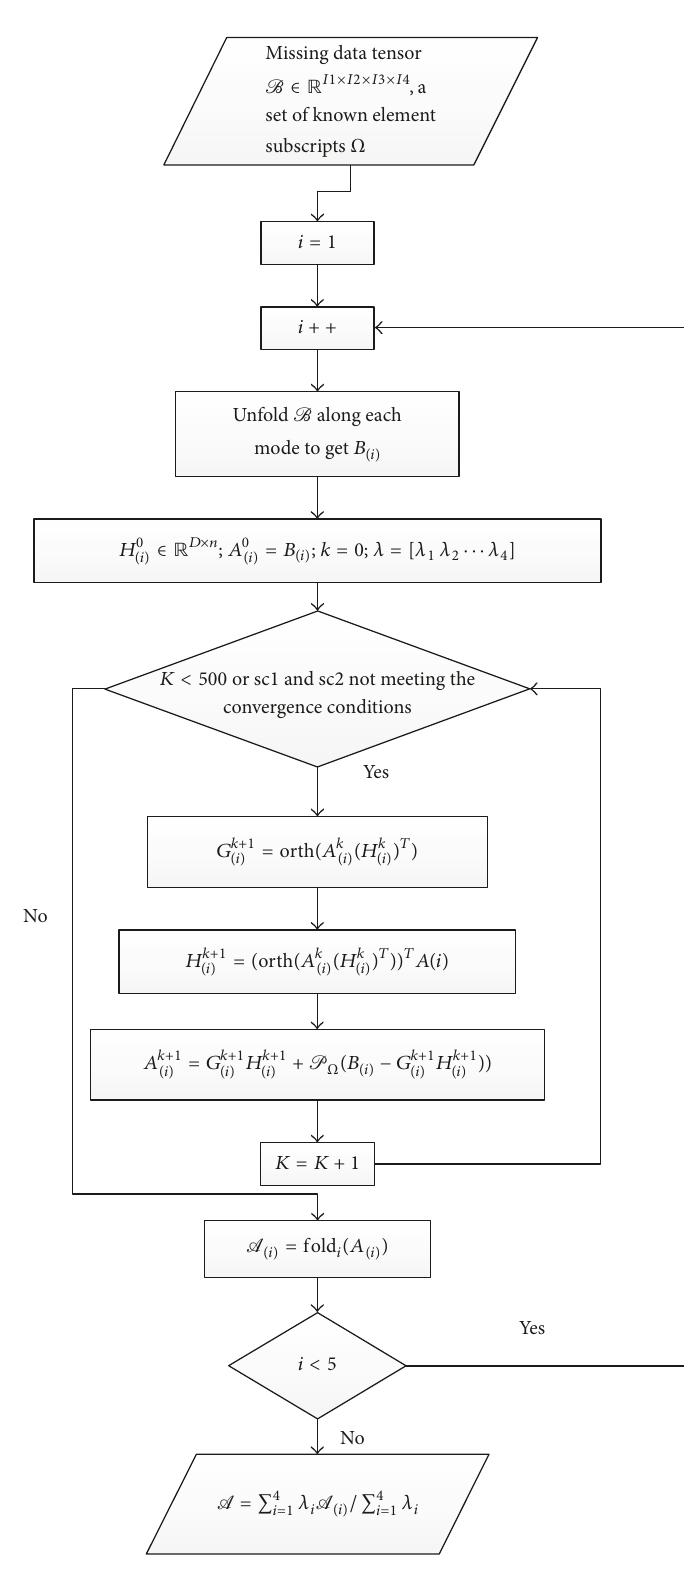
Figure 7: Flow chart of the